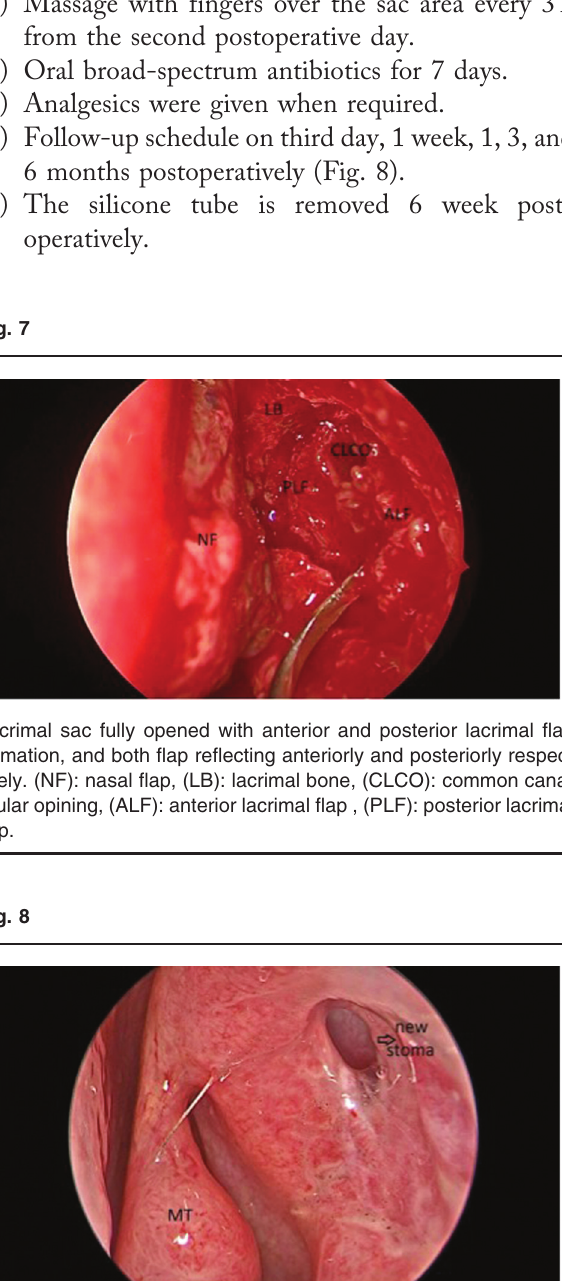
Vertical incision of I-shaped flap by using keratome blade (NF): nasal flap, (KB): keratome blade, (SUP) TI: superior transverse incision, (INF). TI: inferior transverse incision, (VI): vertical incision.